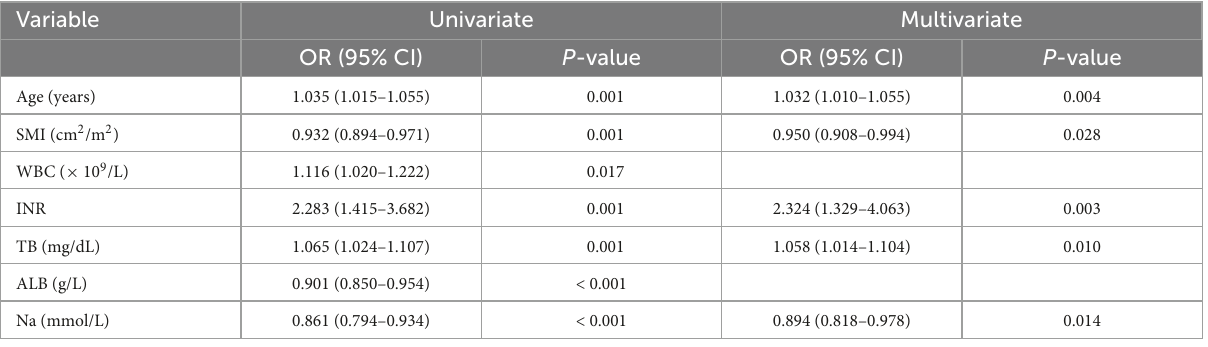
TABLE 2 Univariate and multivariate logistic regression analysis of